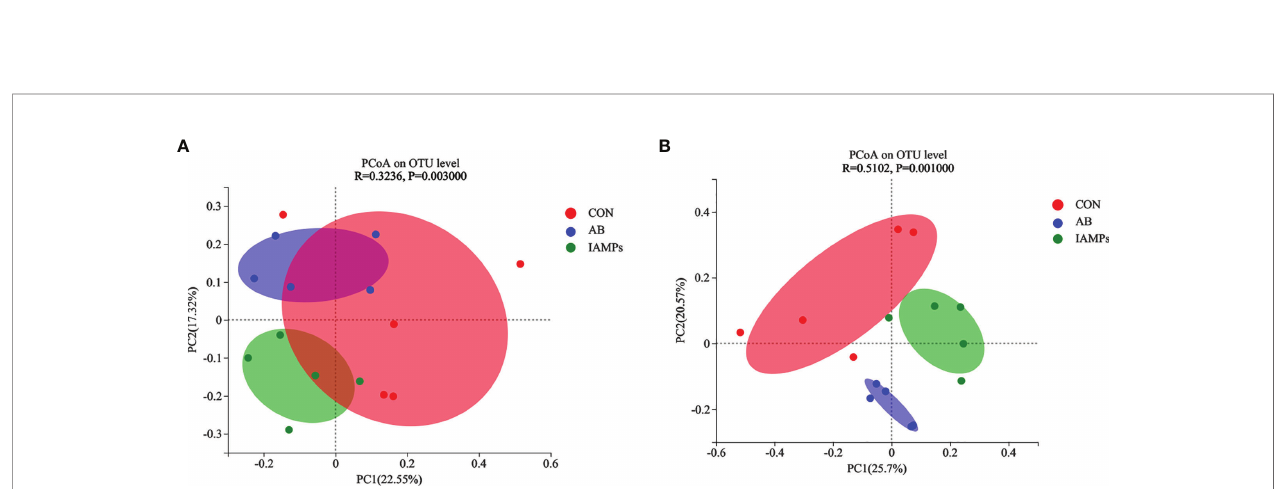
FIGURE 4 | Effects of IAMPs on beta-diversity of cecal and colonic digesta of weaning piglets. (A) Cecum; (B) colon. The individual pig was regarded as the experimental unit (n = 5). CON, corn – soybean meal-based diet; AB, CON + 25 mg/kg fl avomycin + 50 mg/kg quinocetone; IAMPs, CON + 1,000 mg/kg